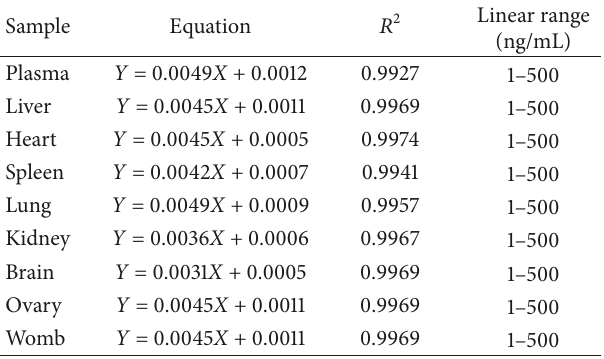
Table1:RegressionequationsofepimedinBinratplasmaandtissue samples ( 𝑛 = 3 ).